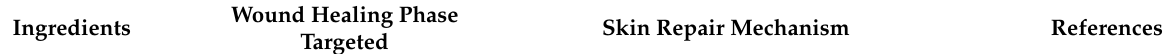
Table 2. Summary of the mechanisms of action of the top 3 most used ingredients